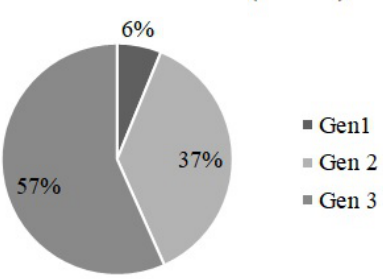
Figure 5. Coverb strategy use by three